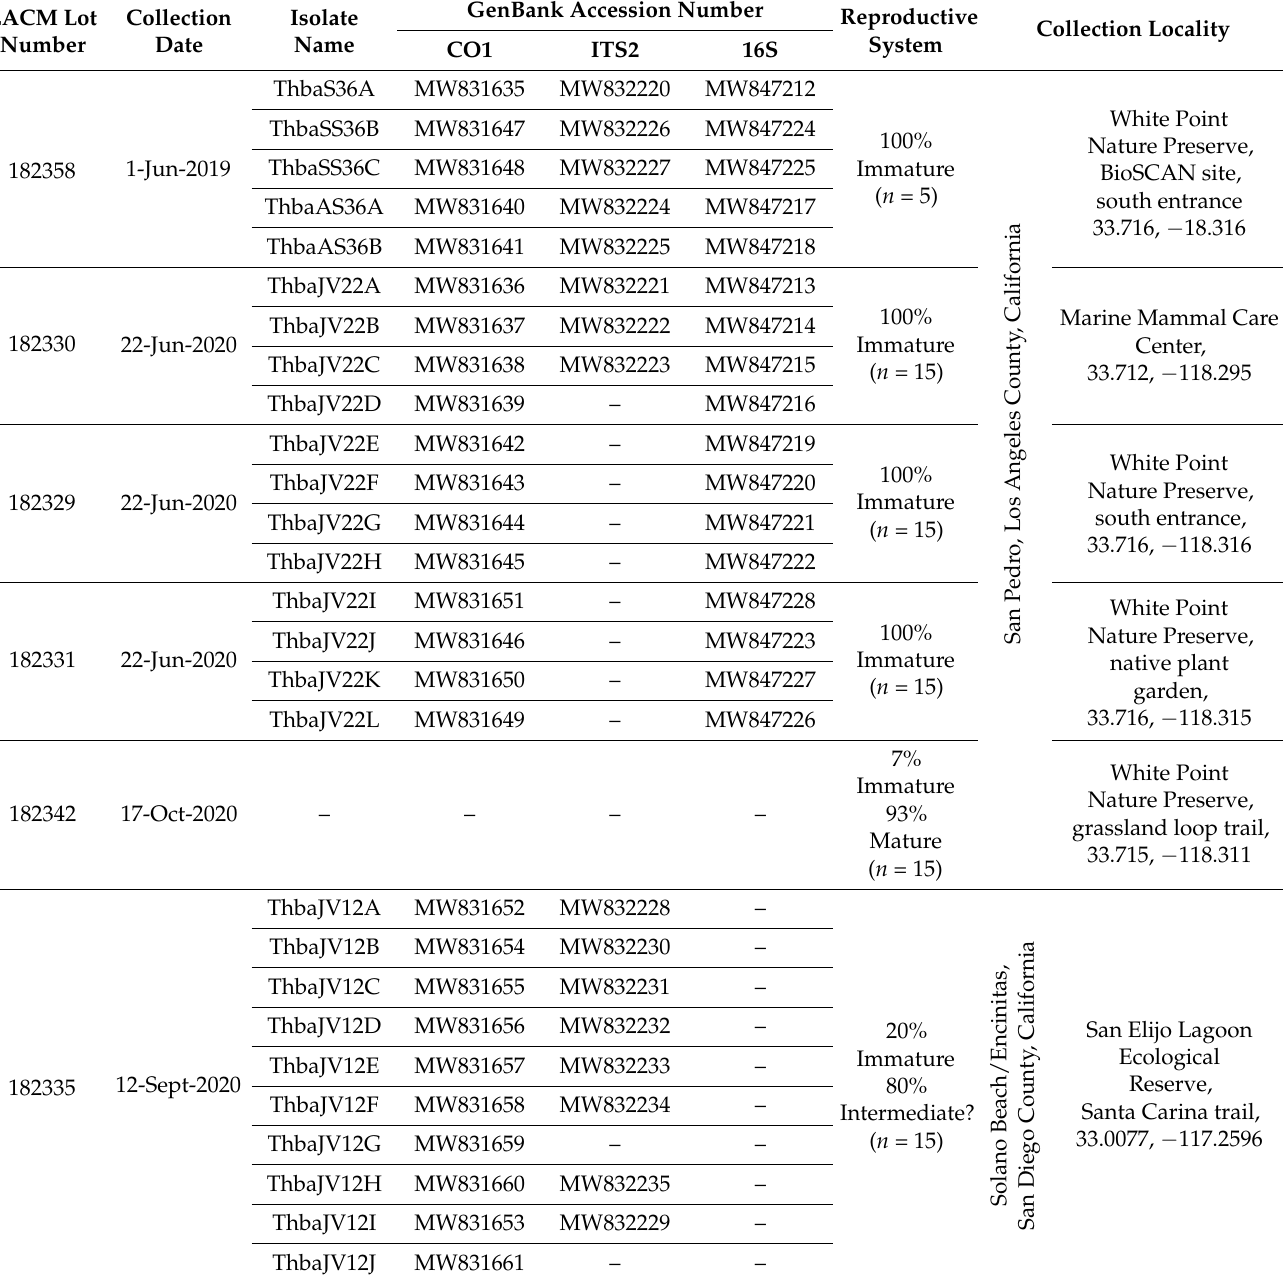
Table 1. Data for Theba pisana (Müller, 1774) specimens collected from Los Angeles and San Diego counties, California, USA and used in this